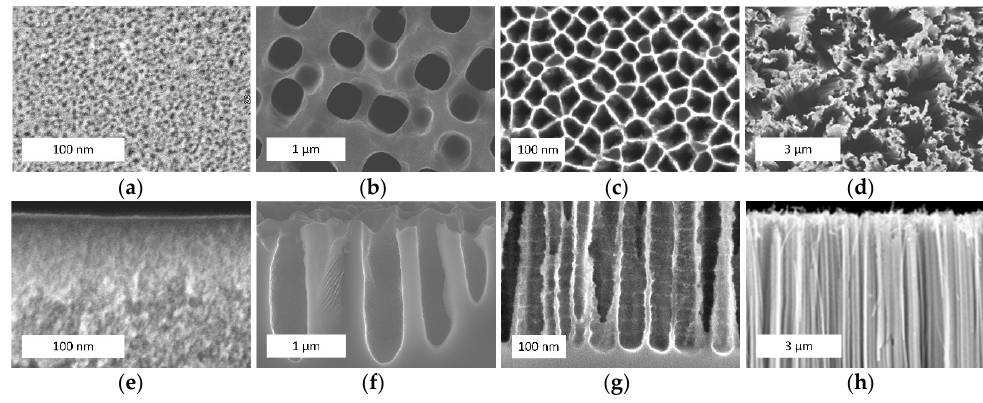
Figure 1. The scanning electronic microscopy (SEM) ( a – d ) top and ( e – h ) cross ‐ sectional views of ( a , e ) microporous silicon; ( b , f ) mesoporous silicon; ( c , g ) macroporous silicon; and ( d , h ) silicon nanowires (provided by the authors).